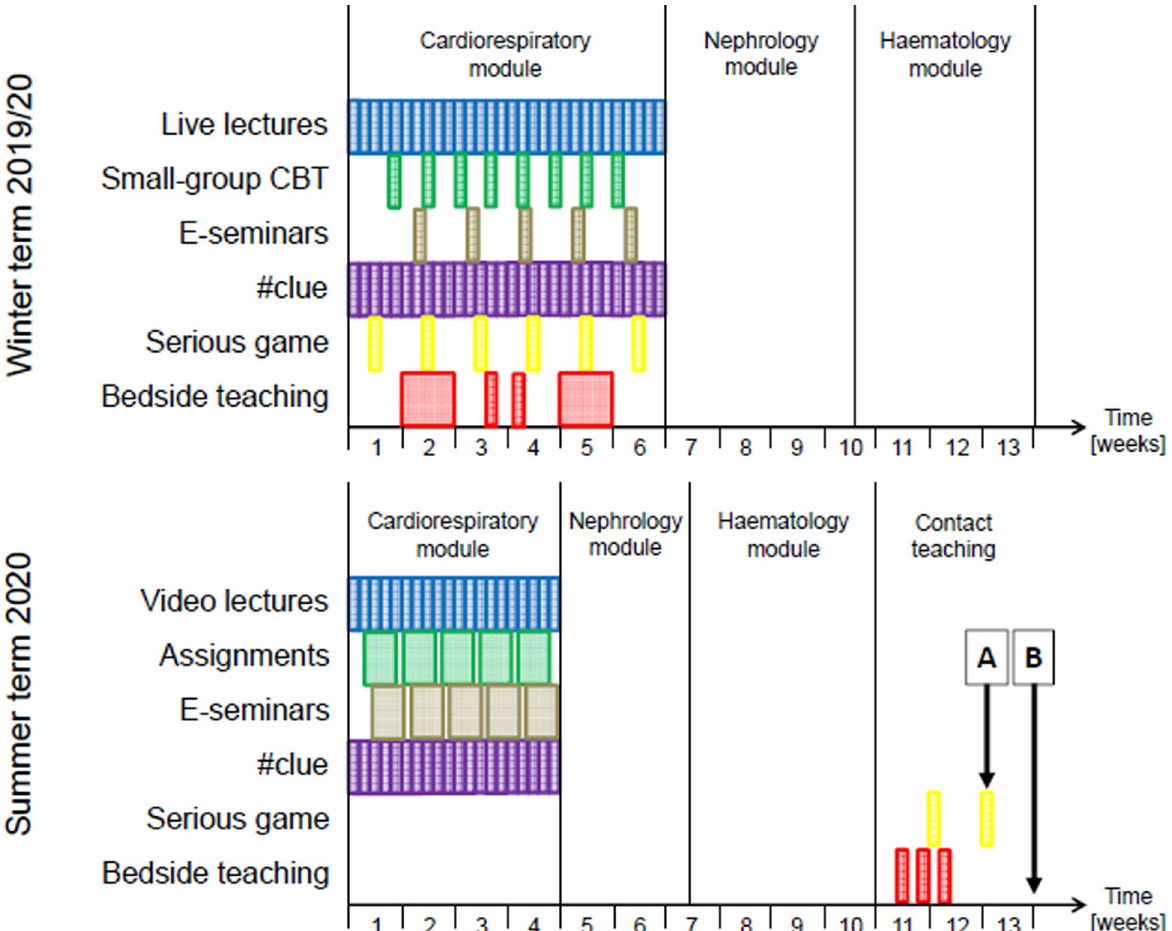
Fig 1. Timeline of teaching before (winter term 2019/20) and after the start of the pandemic (summer term 2020). CBT, case-based teaching. A, data collection point for the formative serious game assessment; B, summative end-of-term